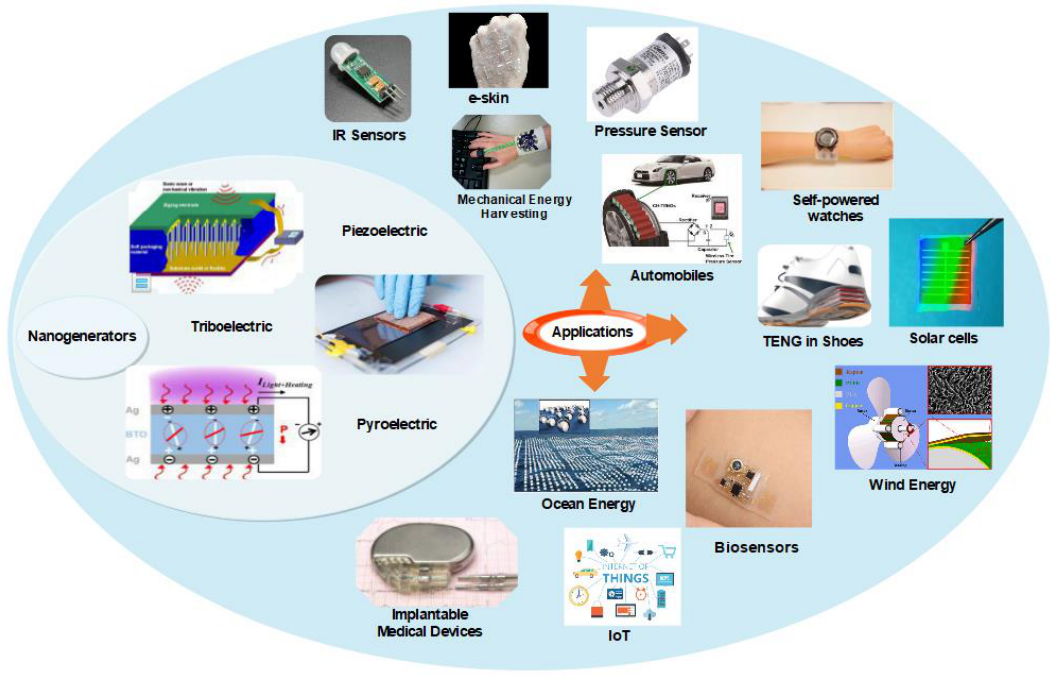
Figure 2. Di ff erent types of nanogenerators and their applications in the era of the Internet of Things (IoT).